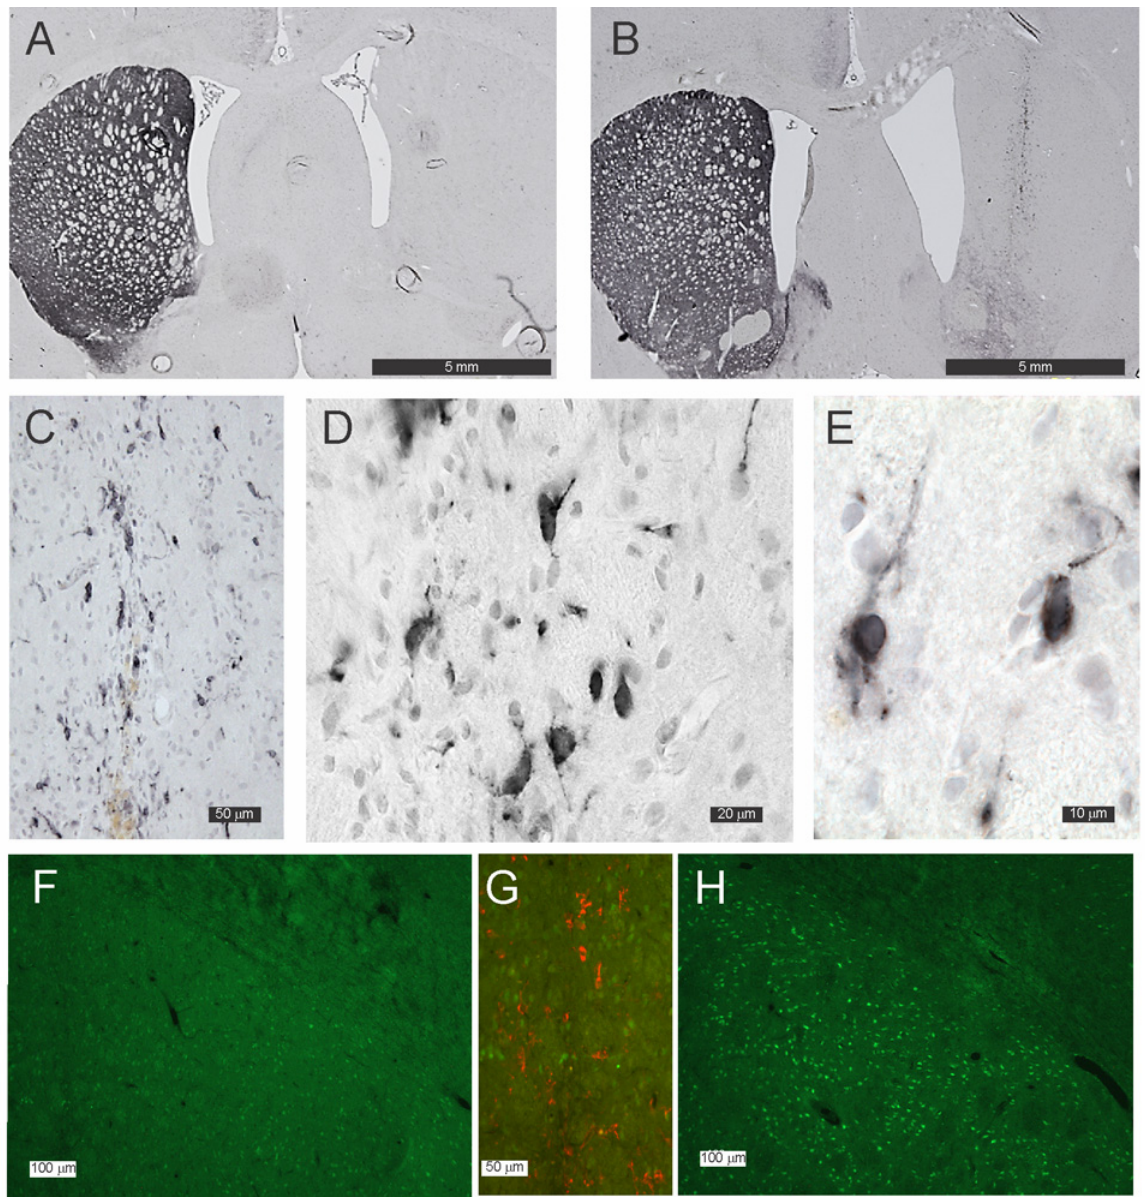
Fig 2. Photomicrographs of DAT-immunoreactivity in the striatum of grafted animals. (A) Null graft located in the striatum of a rat in whom 6-OHDA had been used to denervate the striatum. The graft tract is faintly discernible but there are no DAT-immunoreactive cell bodies, terminals or fibres. (B, C, D and E) show a DAT graft located in the striatum of a rat in whom 6-OHDA had been used to denervate the striatum; note the numerous DAT-immunoreactive cell bodies within the graft (B and D). (D and E) show DAT-immunoreactivity is present in the cytoplasm and along the numerous processes emanating from the cells. (F, G and H) show Fos- B immuno-reactivity (green) in a DAT grafted striatum (F) and a Null grafted striatum (H). (G) shows both Fos_B and DAT immuno-reactivity (red) merged in the one image in the region of the DAT graft shown by the white rectangle in